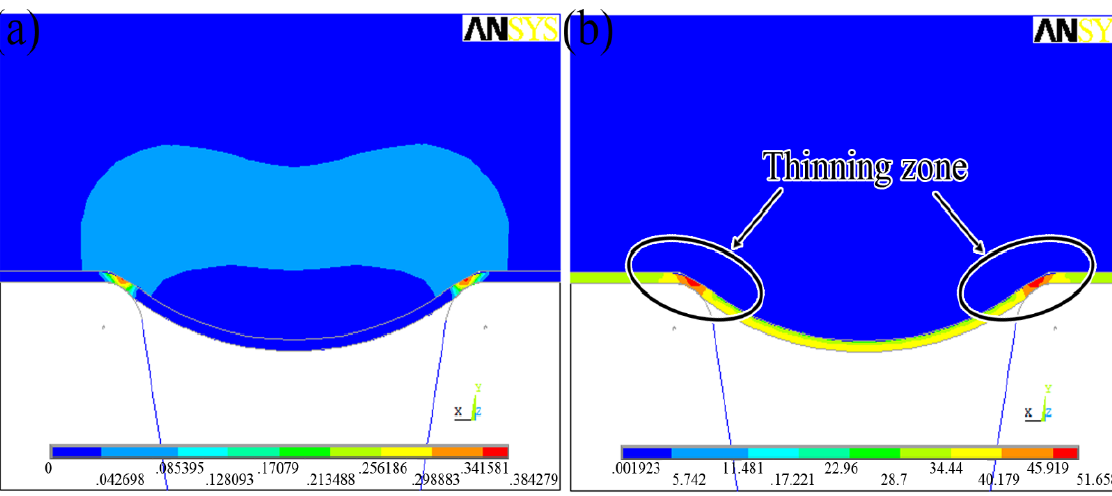
Figure 11. ( a ) The final deformation with the contour of effective plastic strain distribution; ( b ) The final deformation with contour of von Mises stress